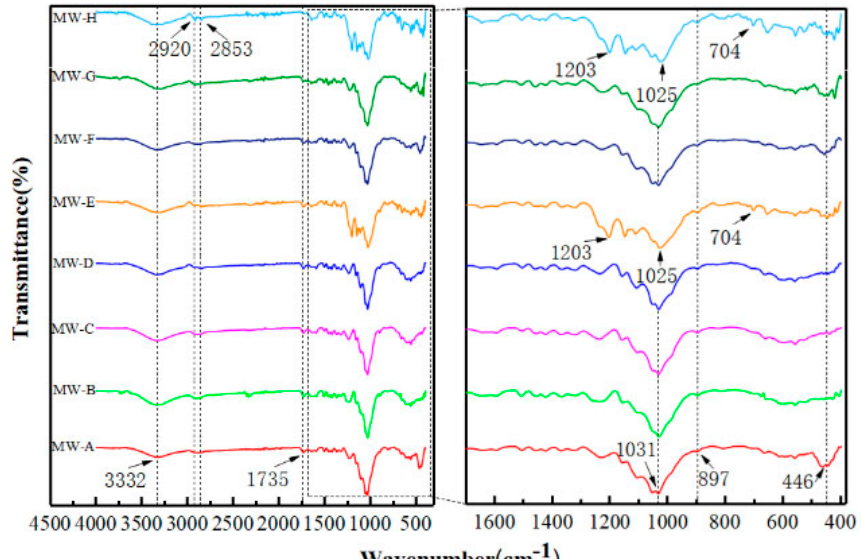
Figure 7. FTIR spectra of modified wood.